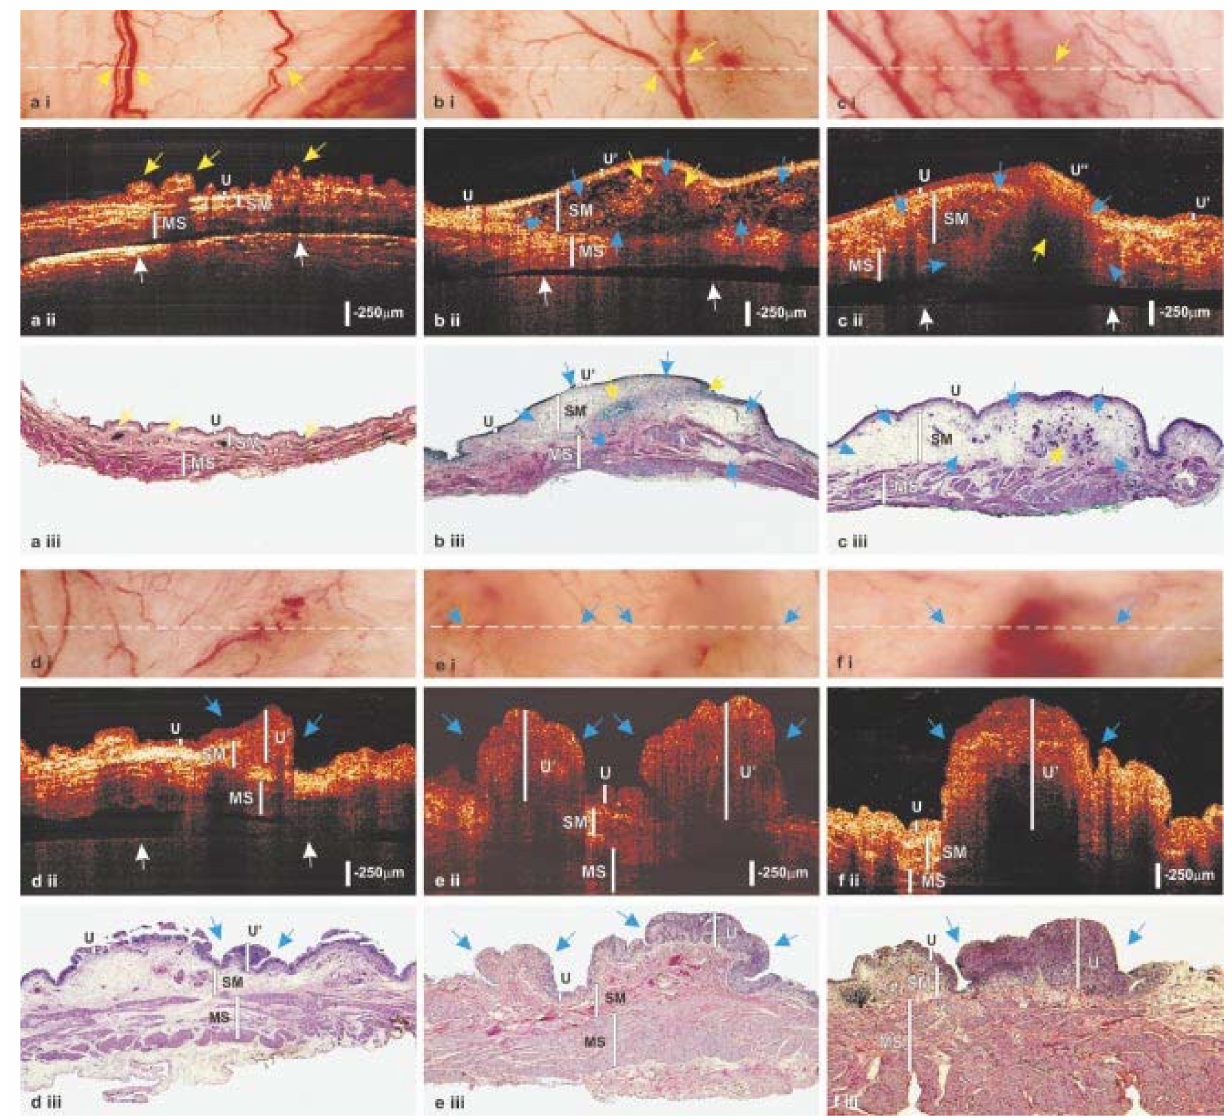
Figure 16. Ex vivo 2D images of rat bladders during tumorigenesis induced by MNU instillation [126]. At each time point, Panels ( i ), ( ii ), ( iii ) (top to bottom) are surface (video) RGB, OCT, and H&E-stained histology, respectively. Image size: X/4.2 mm, Z/1.9 mm. For normal control (group ( a )), the low scattering (U) and the underlying high scattering SM and MS layers are identified and indicated by white bars. Yellow and white arrows point to superficial blood vessels and the supporting silicon pad, respectively. At 24 h after MNU instillation (group ( b )), acute chemical cystitis involving inflammatory infiltrate with SM fluid buildup is identified by OCT and evidenced by histology, whereas surface imaging fails to provide any specific feature. The whole-mount bladder wall is thickened. At 48 h (group ( c )), continued damage to the bladder involving inflammatory infiltrate with SM vasodilation or blood congestion within the SM blood vessels (e.g., severe edema) is identified by OCT and evidenced by histology. Blue arrows point to the SM inflammatory lesion, yellow arrows point to blood congestion. (U”) shows the completely denudated urothelium following MNU installation. At 20 weeks (group ( d )), in addition to inflammatory infiltrate, chronic damage, e.g., early papillary hyperplasia is identified by OCT as thickened urothelium and evidenced by histology. Blue arrows point to the thickened urothelium (U’). The underlying bladder wall, e.g., SM and MS are still visible. At 30 weeks (group ( e )), more severe damage is identified by OCT as indicated by blue arrows and evidenced by histology. At 40 weeks (group ( f )), thickened urothelium and increased vascularization are identified by OCT and evidenced by histology. High magnification histology provides subcellular evidence of the growth of an incipient papillary